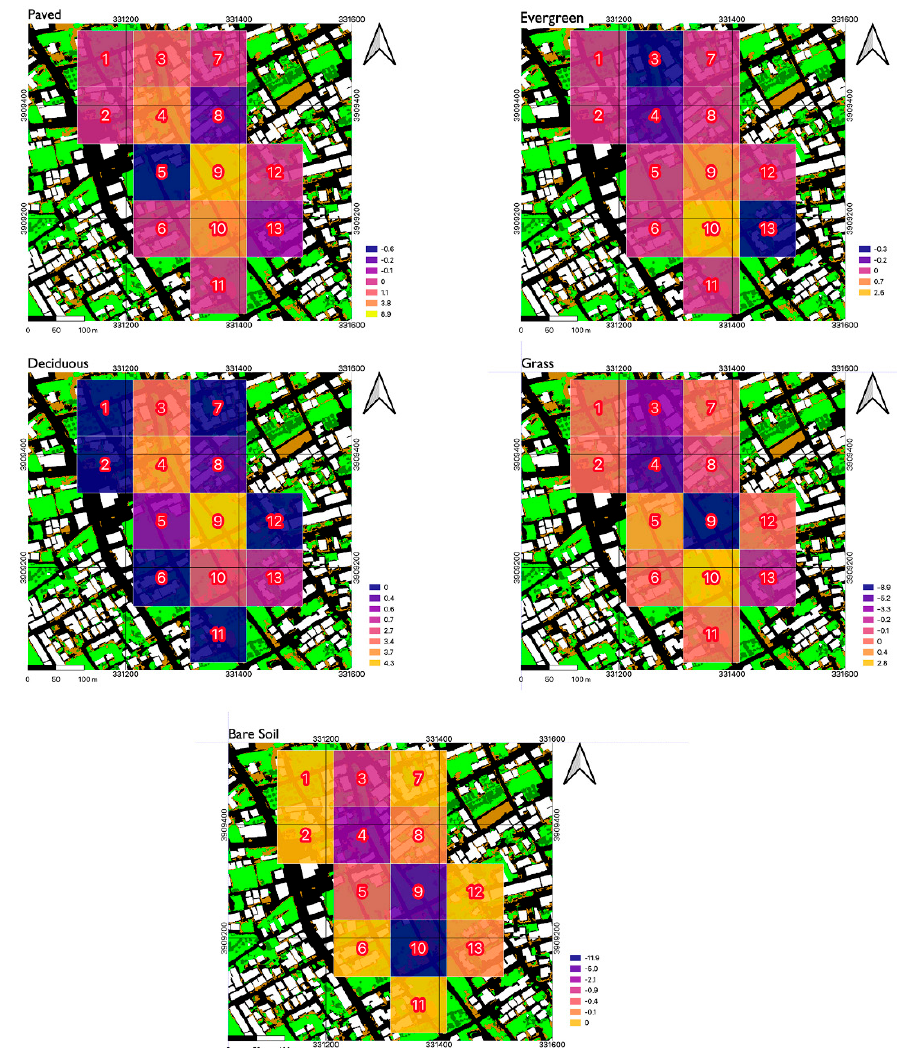
Figure 10. Percentage changes for the land cover classes that are subject to change based on the park development plan for all grid cells.